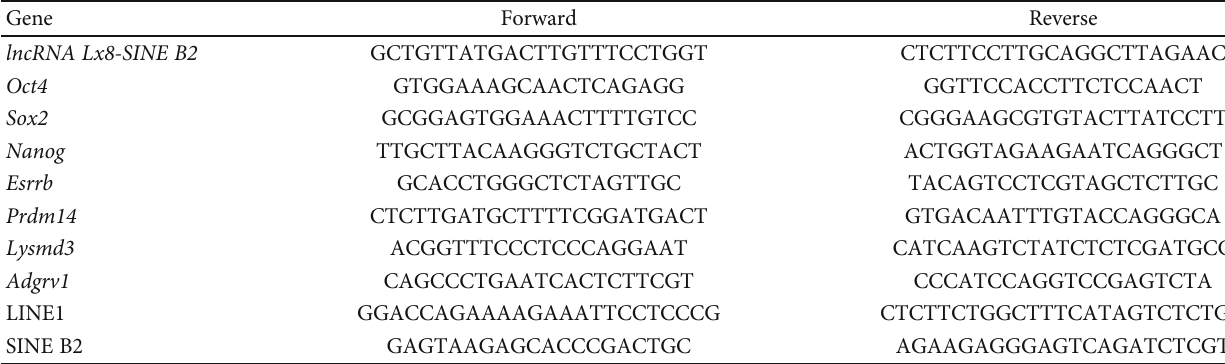
Table 1: Primer sequences for qPCR analysis.